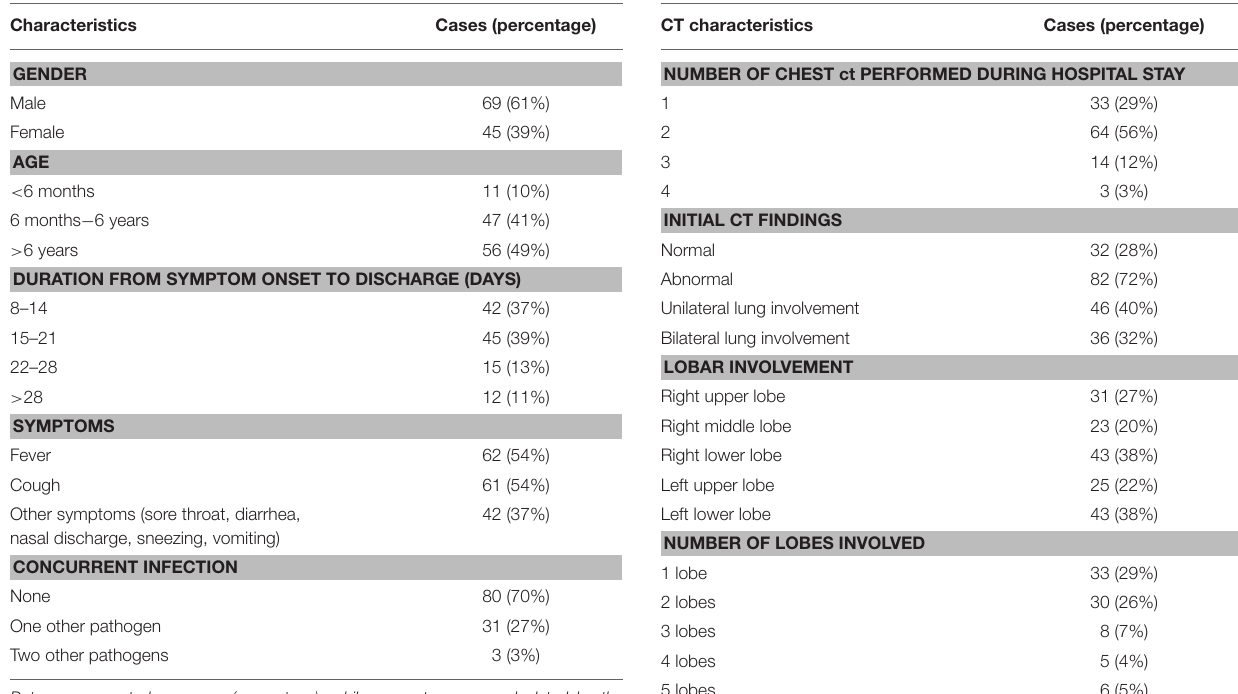
TABLE 1 | Demographics of the included 114 pediatric patients. TABLE 2 | CT characteristics of the included 114 pediatric